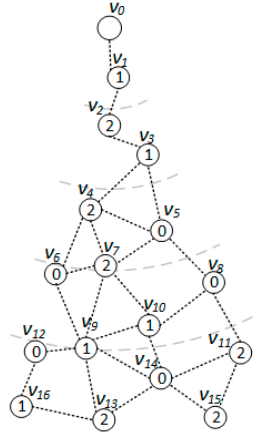
Figure 5. Original physical link .